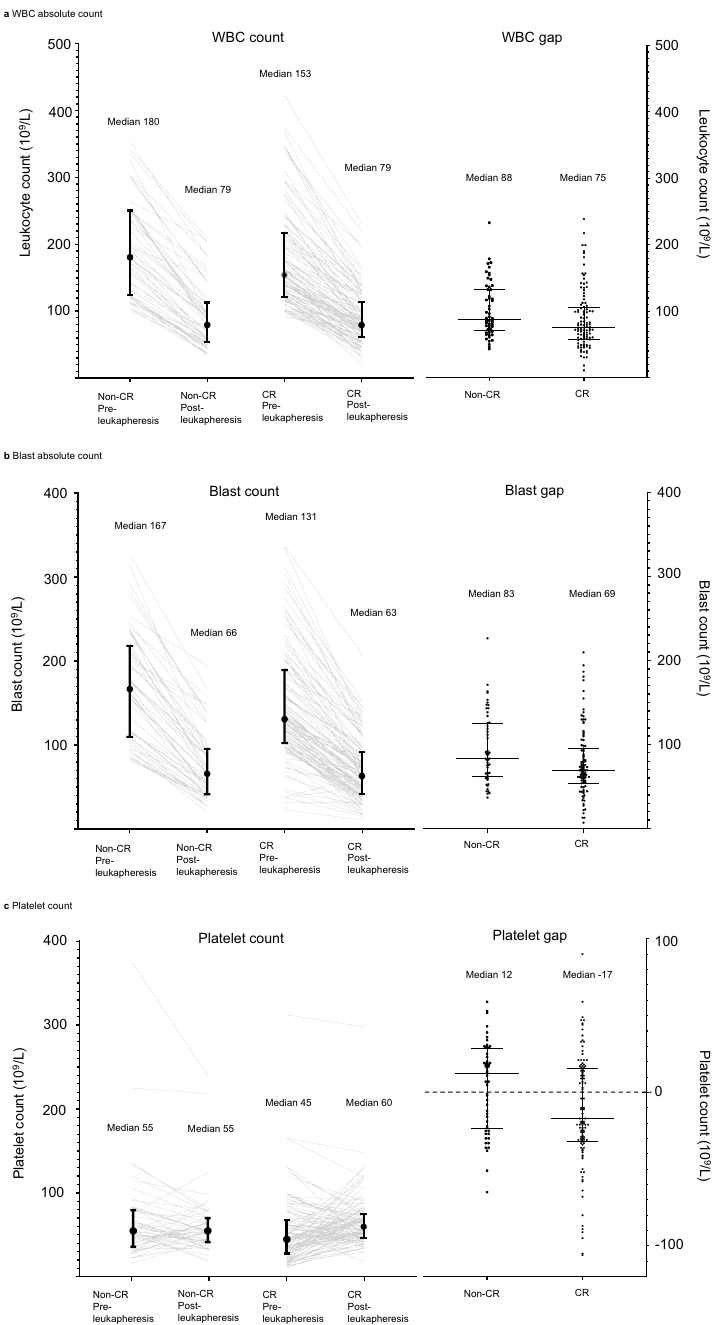
Figure 3. Changes in CBC parameters before and after leukapheresis in the non-CR and CR groups in the acute myeloid leukaemia (AML) group. Each error bar represents the range from the 25th to 75th percentile of each group. CBC complete blood cell, CR complete remission, WBC white blood